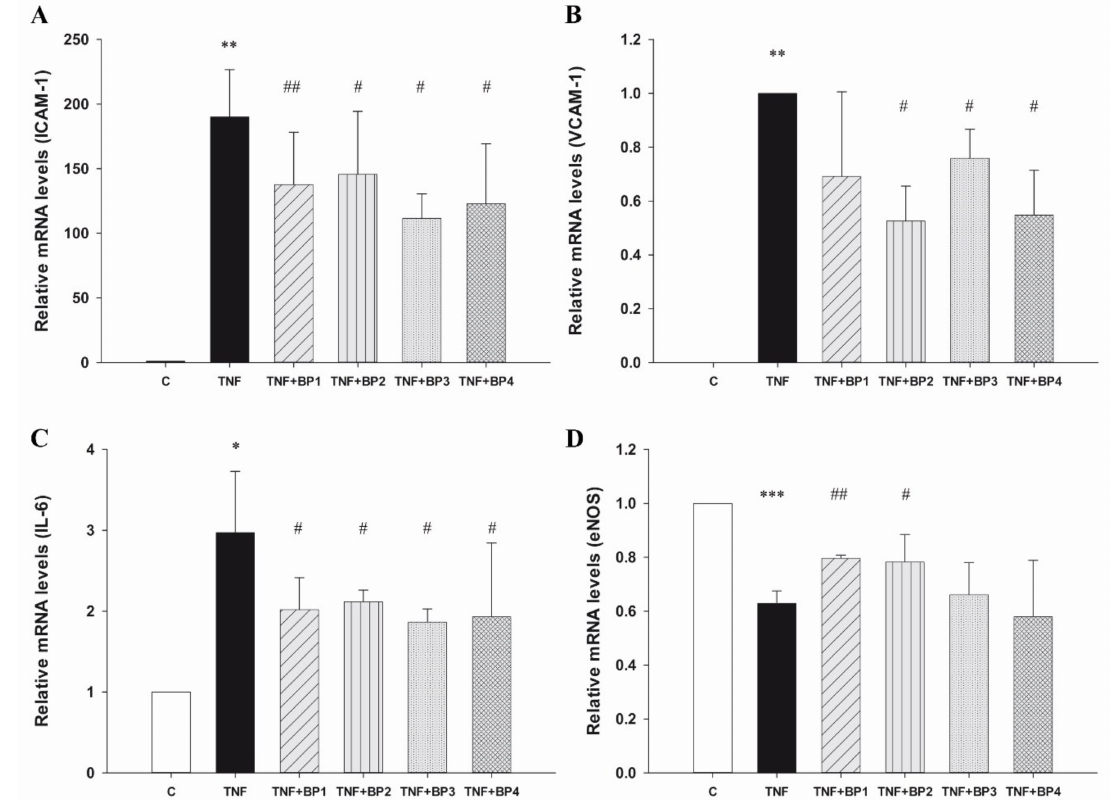
Figure 2. Relative mRNA expression of ( A ) ICAM-1, ( B ) VCAM-1, ( C ) IL-6, ( D ) eNOS in Ea.hy926 cells after treatment with 100 ng / mL TNF- α and 300 µ M synthetic peptides. Data shown represent averaged values of three independent experiments. The asterisks *, **, and *** indicate statistically significant di ff erences compared with unstimulated cells ( p < 0.05, 0.01, or 0.001, respectively). #, ##, or ### indicate statistically significant di ff erences compared with stimulated cells ( p < 0.05, 0.01, or 0.001,